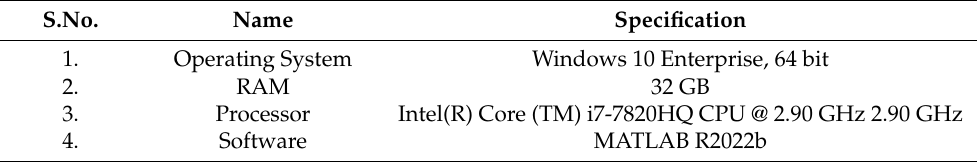
Table 2. System Specifications.